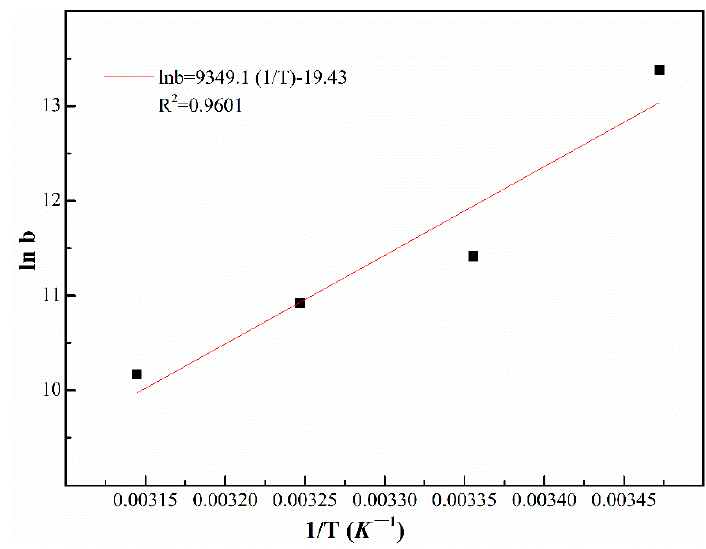
Figure 7. Van’t Hoff diagram for the adsorption of phosphate with La-chitosan magnetic spheres. Table 3. Thermodynamic parameters for phosphate adsorption on La-chitosan magnetic spheres at 15 °C, 25 °C, 35 °C, and 45 °C, respectively.